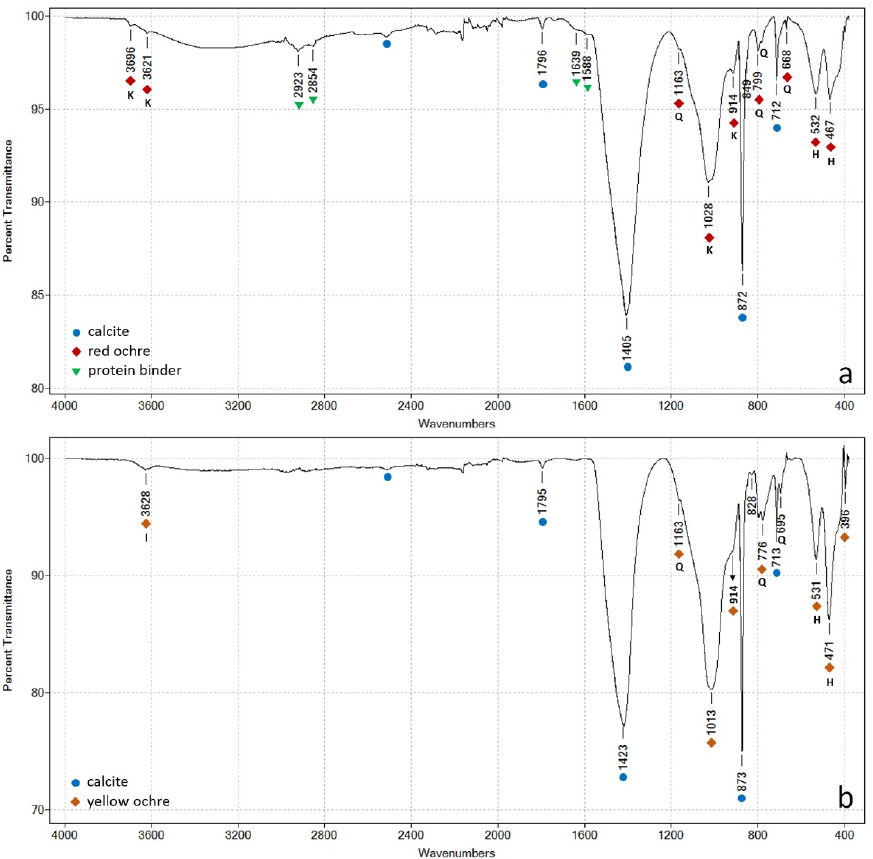
Figure 3. FTIR spectrum registered on the red ( a ) and yellow ( b ) pigmented areas (samples S2 and S6). The absorptions of the various accessory minerals associated with the natural ochre pigments are marked on the spectra as follows: K—kaolinite; Q—quartz; H—hematite; I—illite.